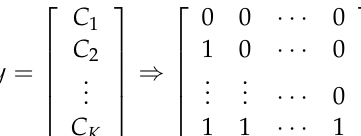
Figure 5. The proportion of classes in each method of category combination after sampling.